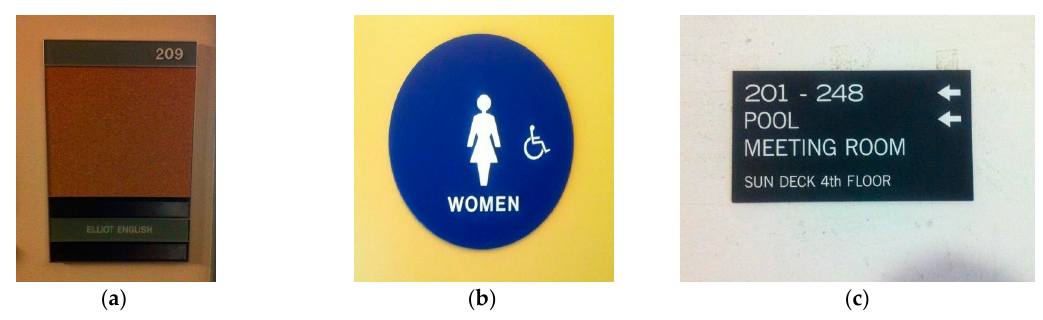
Figure 4. Visual clues used to guide pedestrians in real environments: ( a ) Place number; ( b ) Pictogram; ( c ) Guide sign.